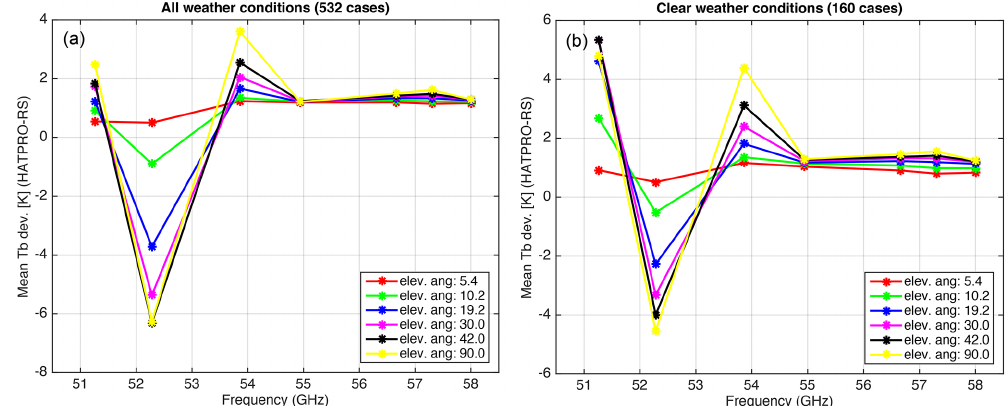
Figure 5. (a) Mean Tb deviation between HATPRO and RSs for all weather conditions (532 cases). (b) Mean Tb deviation between HATPRO and RSs, only for clear conditions (160 cases). Table 2. Mean Tb and standard deviation between TEMPERA and RSs for clear conditions. Elev.